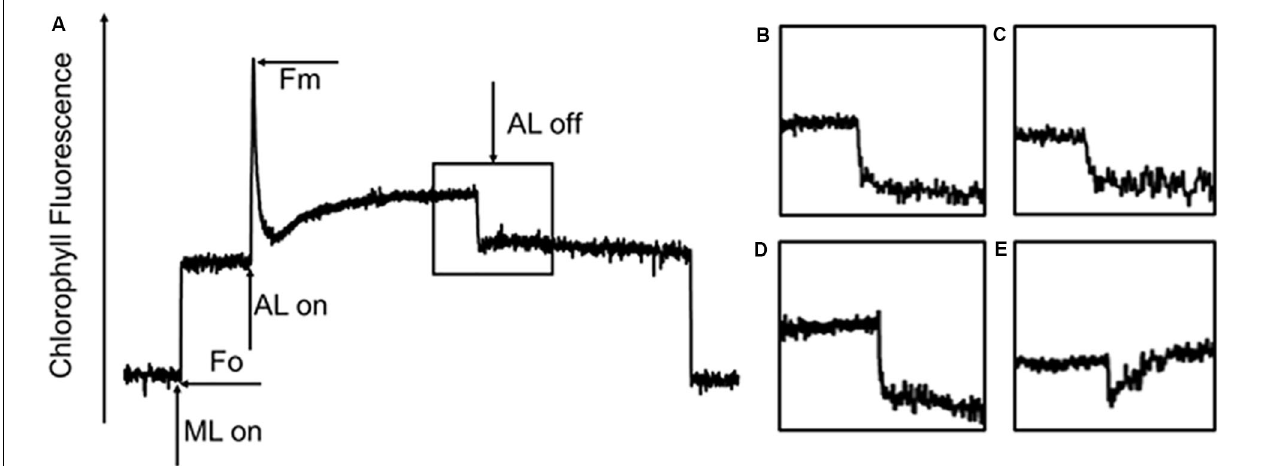
FIGURE 5 | Chlorophyll fluorescence analysis of C. nivalis and C. reinhardtii at 22 and 4 ◦ C. (A) Transient post-illumination increase in Chl fluorescence. ML, measure light; AL, actinic light; Fo, initial fluorescence level; Fm, maximum fluorescence level. The curve exhibits a representative trace of Chl fluorescence in C. reinhardtii at 22 ◦ C. The black box represents cells exposed to AL (100 µ E) for 5 min, after which the AL was turned off. Short-lived increases in chlorophyll fluorescence were detected under low ML. (B–E) . Magnified traces from the boxed area. (B) C. reinhardtii at 22 ◦ C. (C) C. reinhardtii at 4 ◦ C. (D) C. nivalis at 22 ◦ C. (E) C. nivalis at 4 ◦ C.